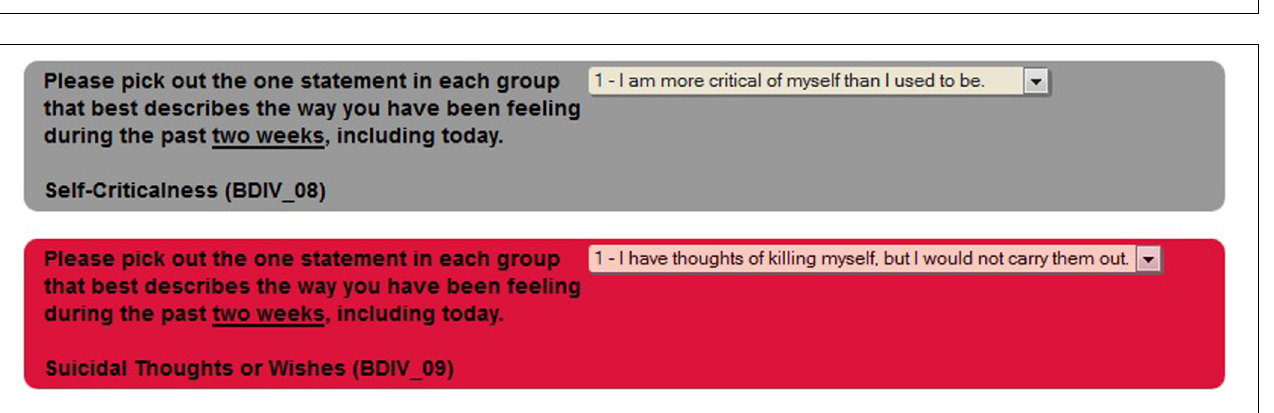
FIGURE 7 | Critical flagging in review queue.